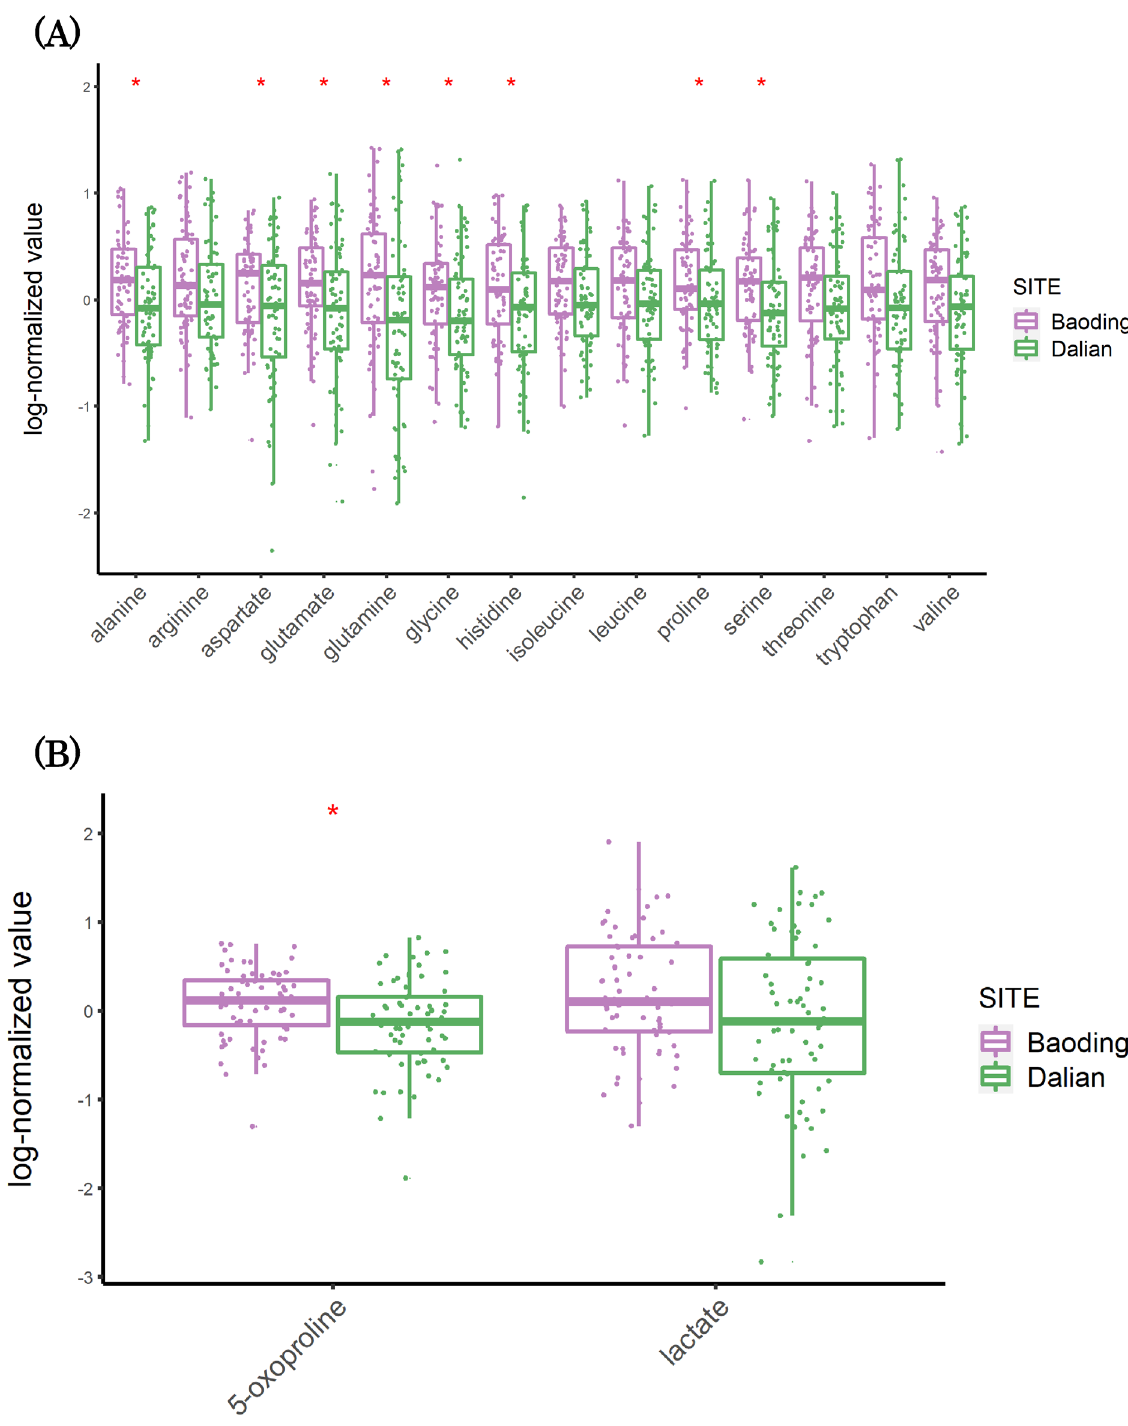
Figure 2. ( A ) Boxplots of log-transformed values of free amino acids ( B ) Boxplots of log-transformed values of NMF. A red star indicates, for a given metabolite, that the difference in mean between the 2 cities, Baoding (More Polluted) and Dalian (Less Polluted), is significant (q-value < 0.05, t-test with correction for multiple testing using Benjamini–Hochberg method). Figures were created using the R software: R Core Team (2017), R Foundation for Statistical Computing, Vienna, Austria. URL https:// www.R- proje ct.